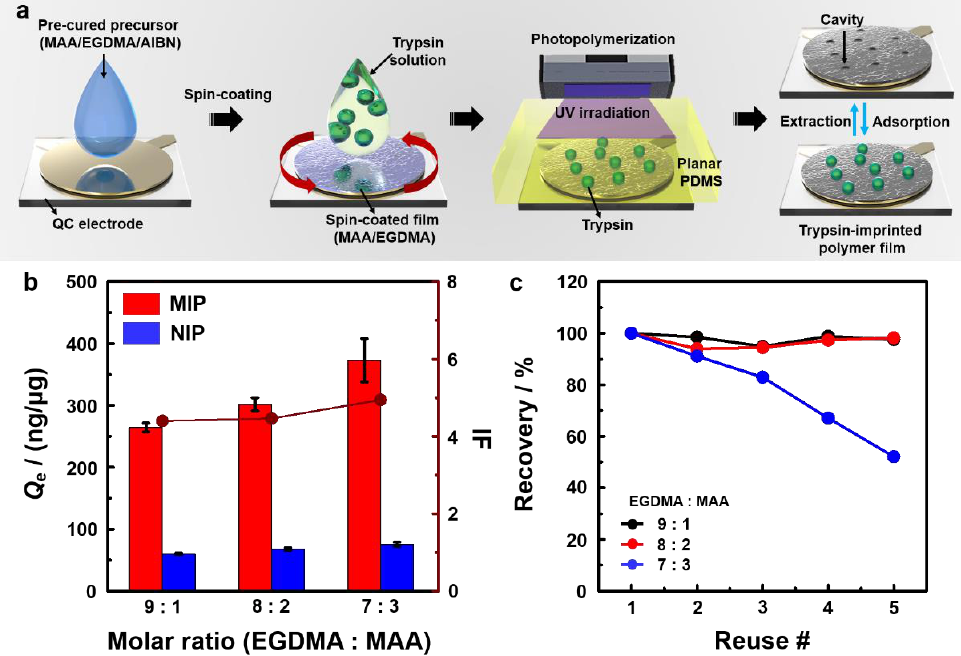
Figure 1. ( a ) Schematic diagram of the molecularly imprinted polymer (MIP) fabrication. ( b ) Ad- sorption capacity at equilibrium ( Q e ) of MIP and nonimprinted polymer (NIP) sensors, prepared with different molar ratios of crosslinker and functional monomer; adsorption for 30 min in a 75 mL phosphate-buffered saline (PBS, 10 mM, pH = 7.4) solution containing 0.24 µ g/mL trypsin (TRY) protein ( n = 3). ( c ) Recovery percentage of MIP sensors, prepared with different molar ratios of crosslinker and functional monomer, for each resonant frequency change (Δ f ) measurement after TRY adsorption (number of reuses, n = 5).